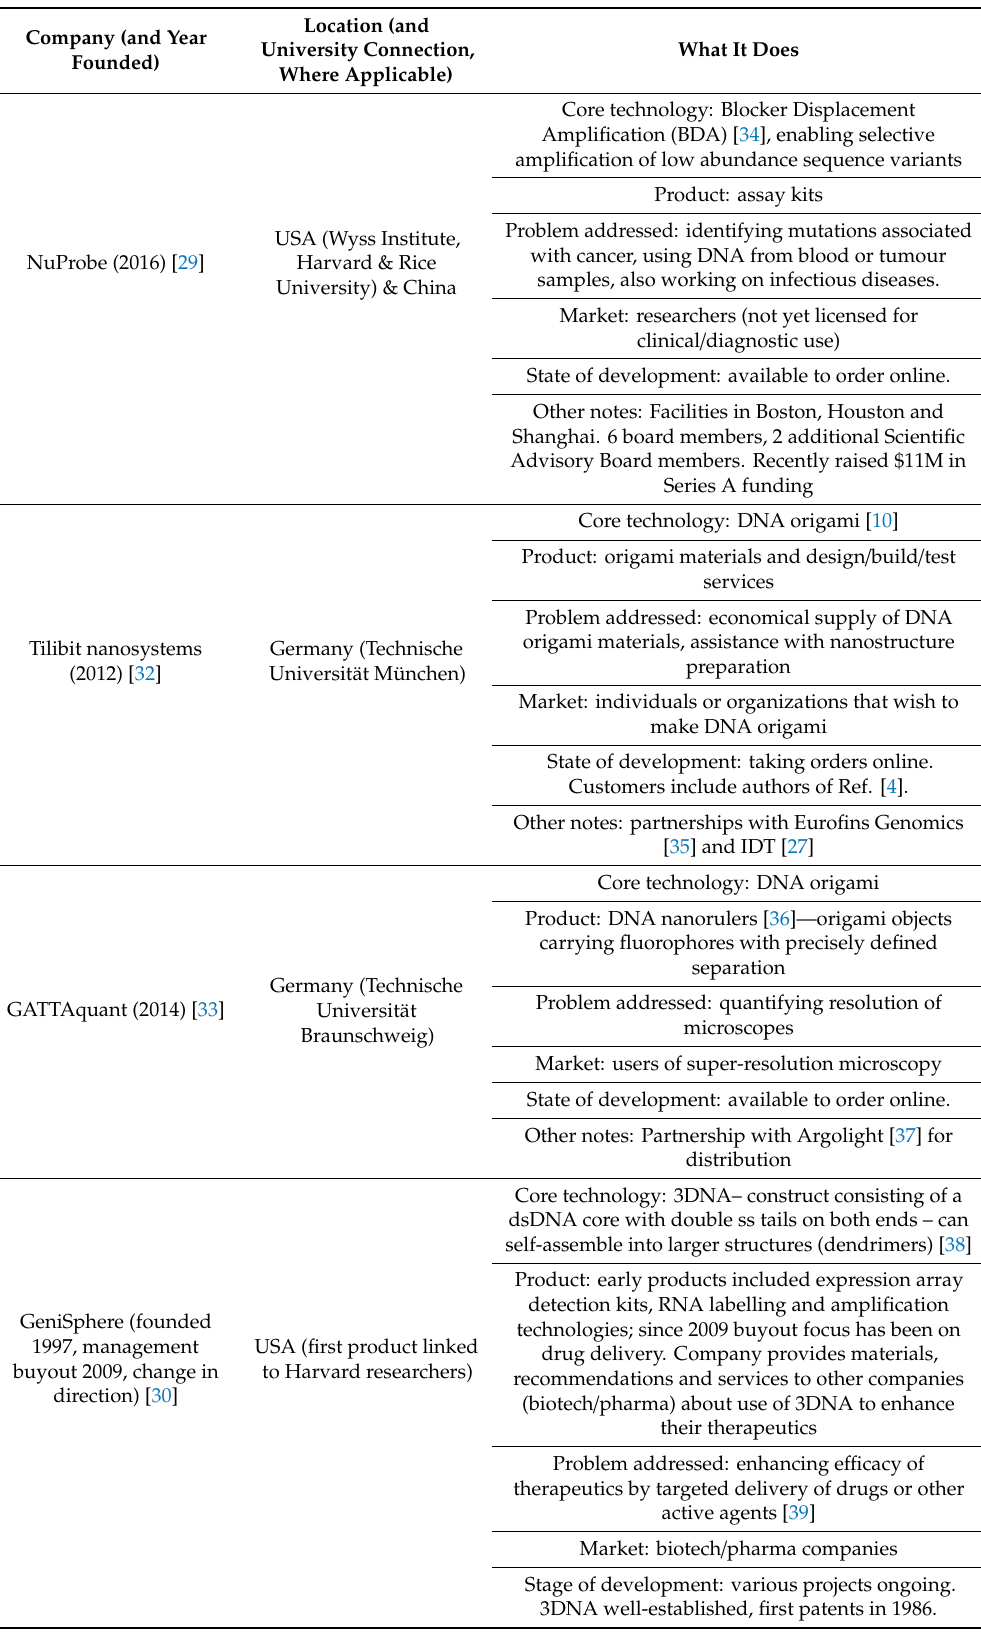
Table 1. Examples of DNA nanotechnology-based start-ups and spin-outs. The content of this table is based on information provided in the websites of the companies